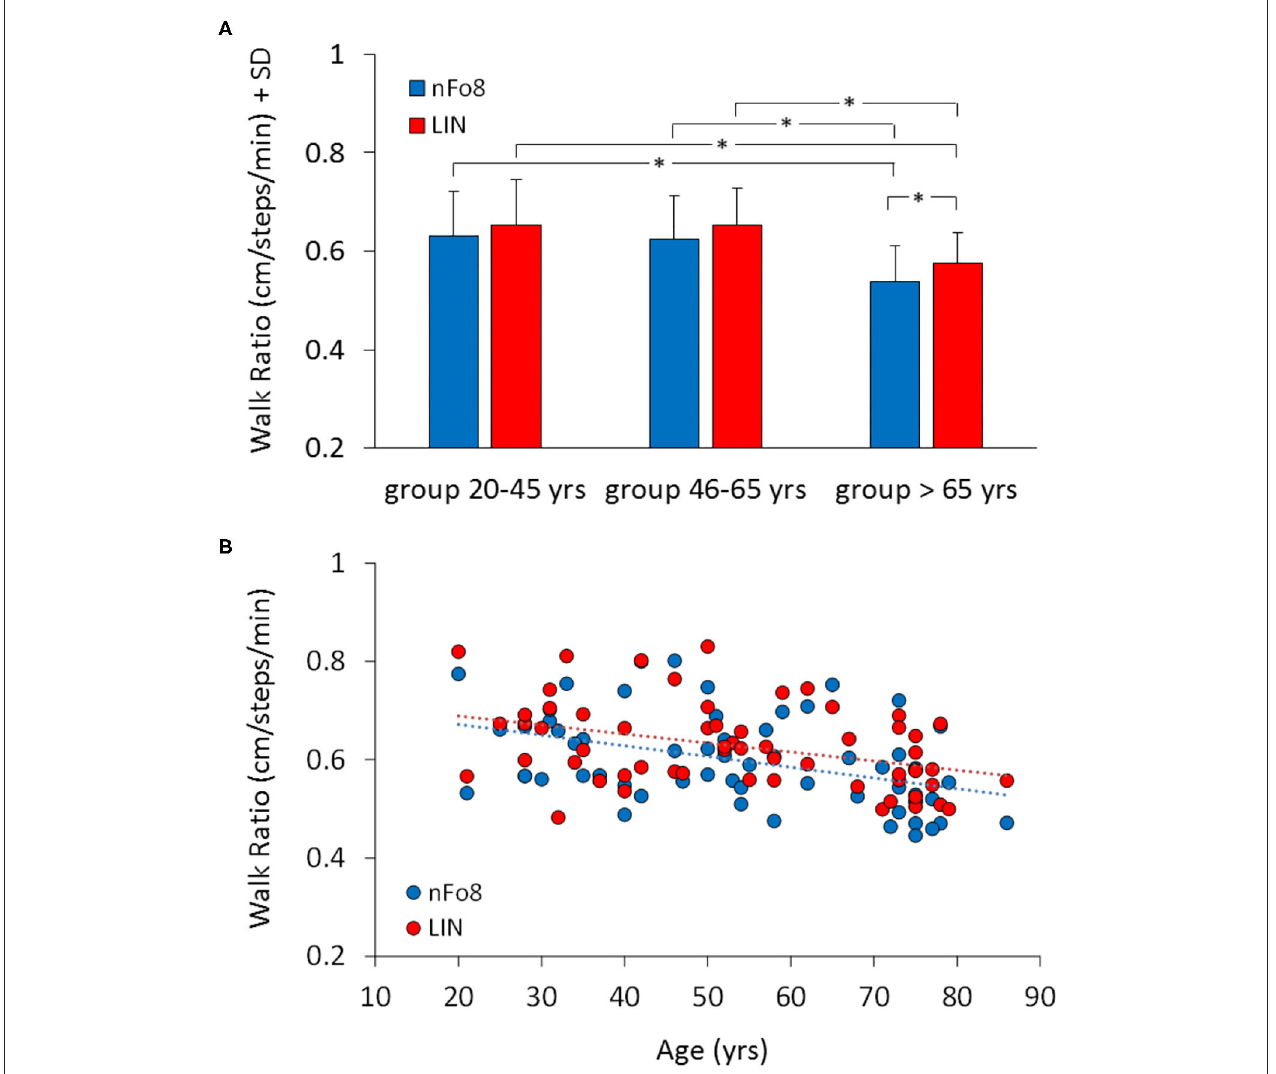
FIGURE 5 | Mean Walk Ratio (WR) (A) and the relationship between WR and age across all participants (B) . Blue bars and dots refer to nFo8, red bars and dots to LIN walking path. WR was just a little smaller in the group > 65 yrs than in the other two age groups. Asterisks indicate significant